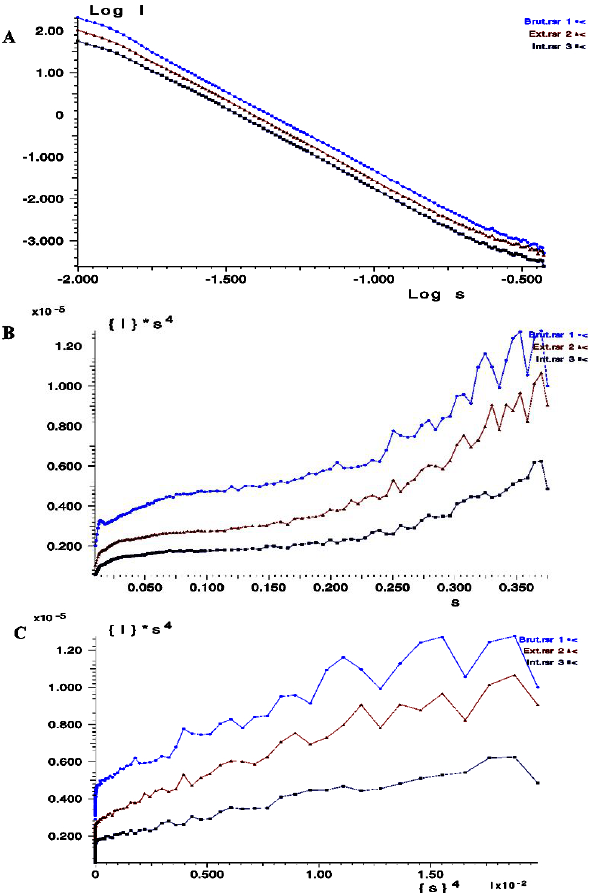
Figure 6: Small-angle-X-ray scattering profiles of the three samples. (A): Data plotted as a log( I ( s )) vs log( s ) . (B): Porod plot to show q −4 dependence behavior ( I ( s ) × s 4 vs. s). (C): Plot of I ( s ) × s 4 vs. s 4 ). Sample S1: untreated phosphate dust (blue). Sample S2: calcium phosphate dust from the outside of filter (red), and sample S3: calcium phosphate dust from the inside of filter